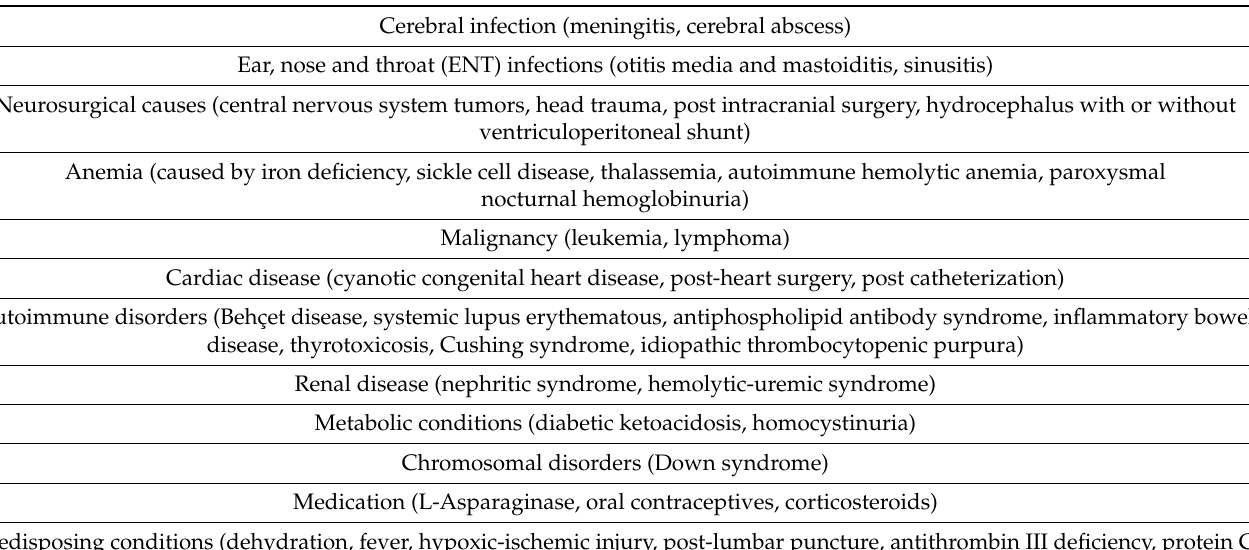
Table 1. Conditions associated with cerebral venous in children. Cerebral infection (meningitis, cerebral